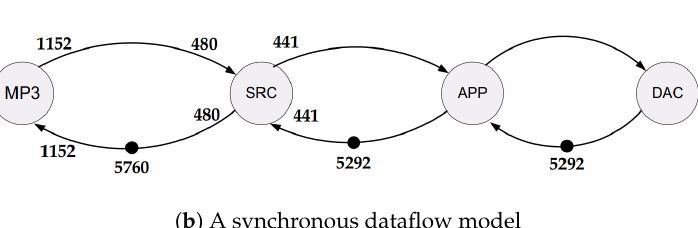
Figure 1. Models of computation. SRC, Sample Rate Converter; APP, Audio